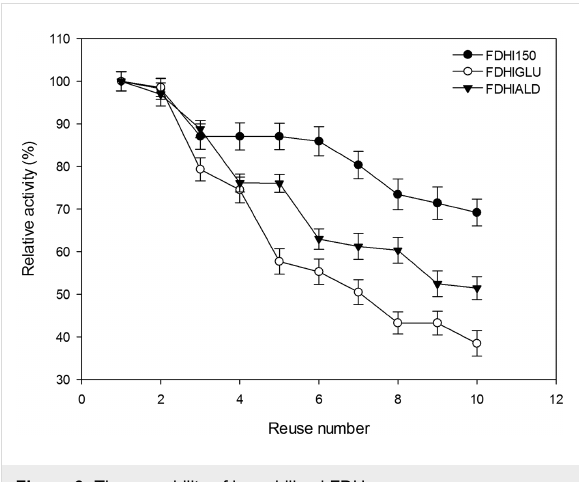
Figure 6: The reusability of immobilized